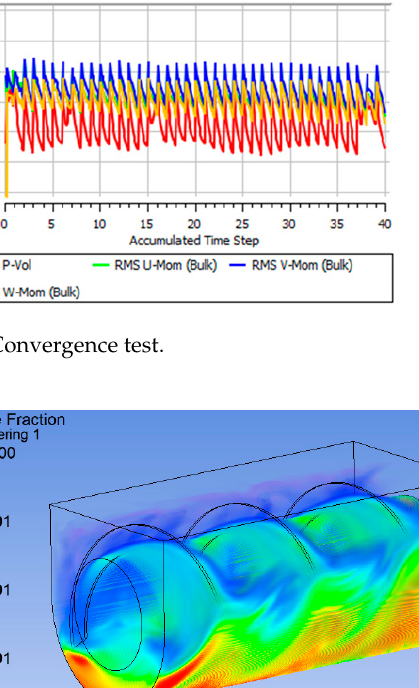
Figure 10. 1/6 partial model of dryer.